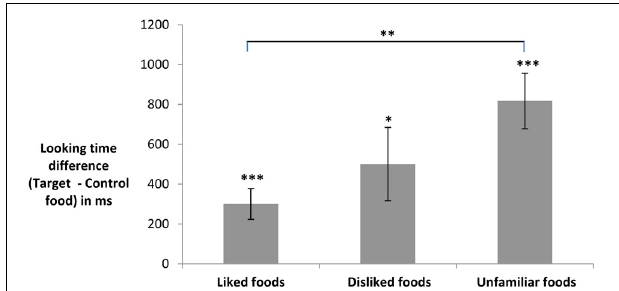
FIGURE 1 | Mean total looking time differences (in ms) for initially liked, disliked, and unfamiliar foods. Differences greater than 0ms indicate that children looked longer at target than control foods. One-sample t -tests against chance (0): ∗ p = 0 . 02, ∗∗∗ p < 0. 001. Pairwise comparison: ∗∗ p = 0 .